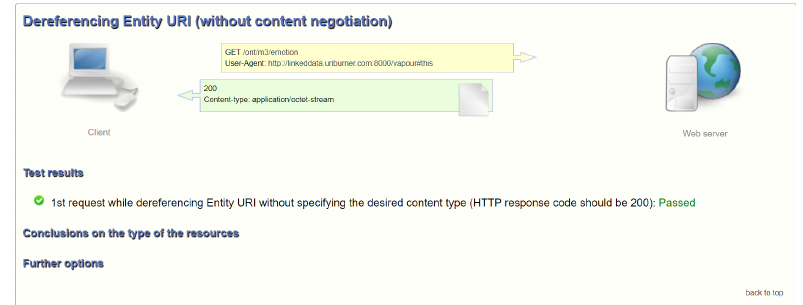
Figure 9. Deferencable URI evaluated with Vapour.